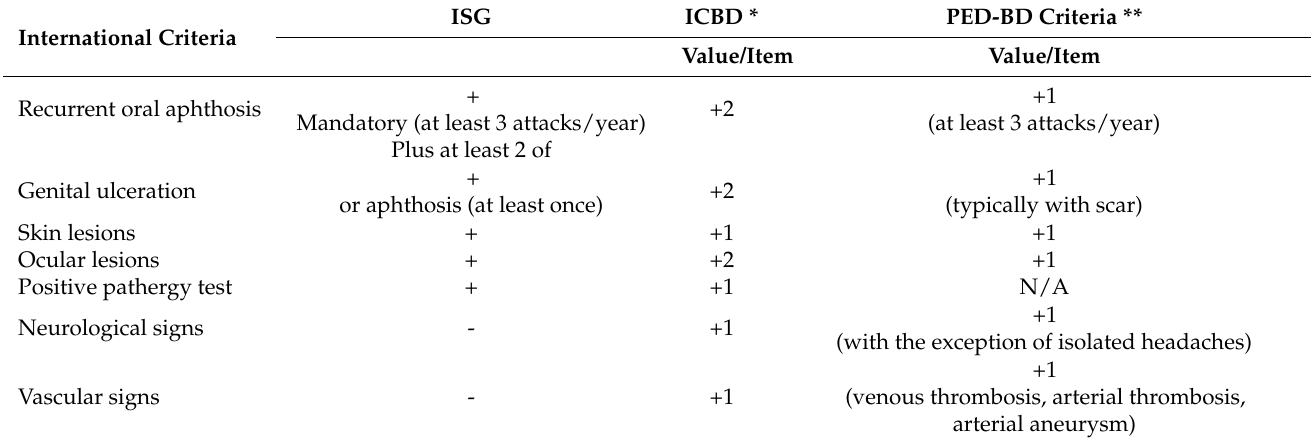
Table 1. Comparison of different international criteria for Behçet’s